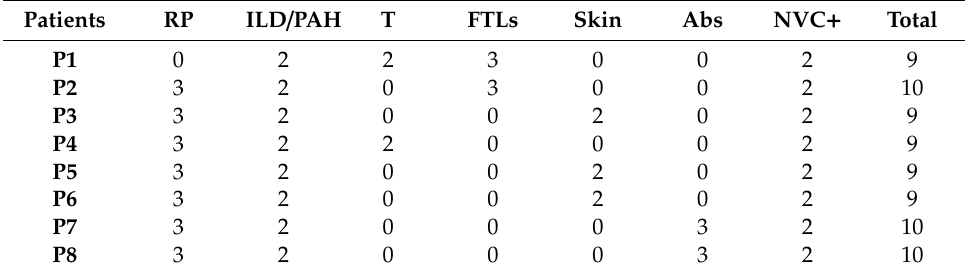
Table 3. Clinical features of SSc patients in which NVC resulted determinant for the classification.